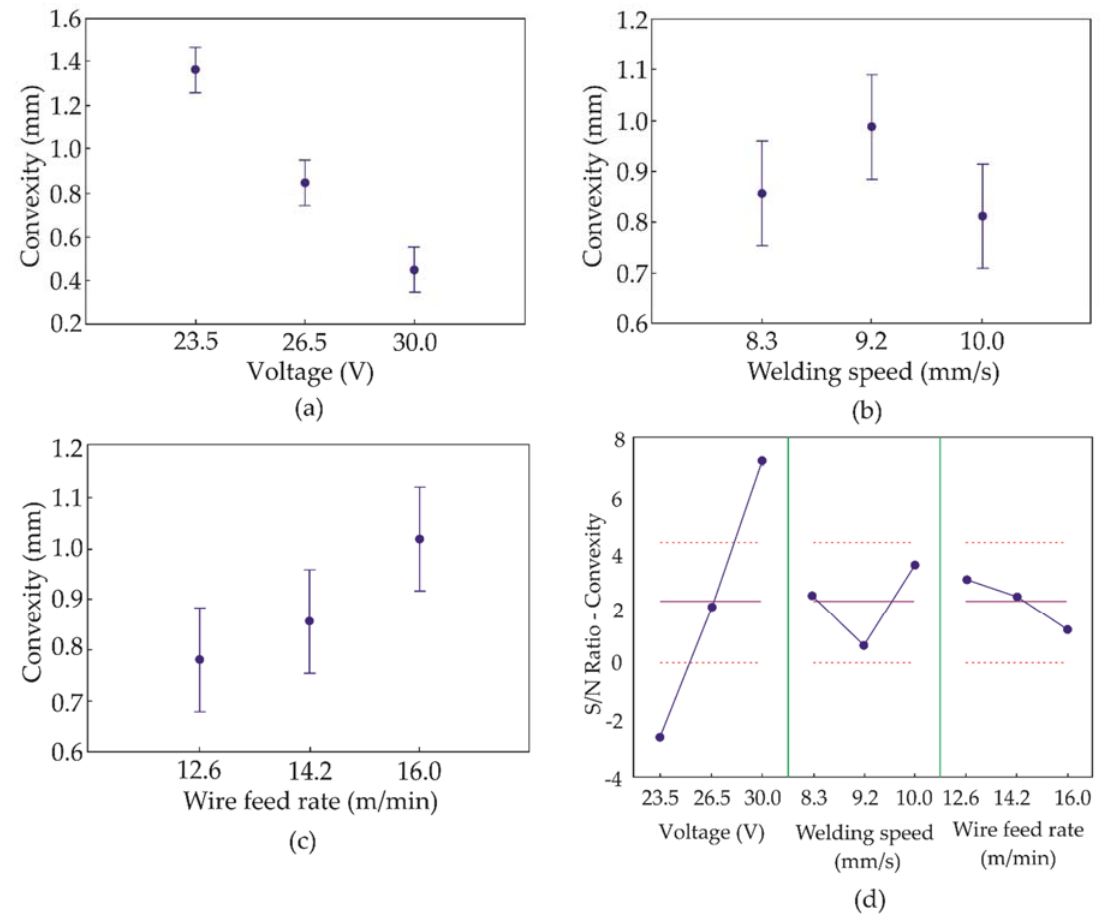
Figure 7. ( a ) Convexity as a function of voltage; ( b ) convexity depending on the welding speed; ( c ) convexity as a function of the wire speed rate; and ( d ) the S/N ratio of the width of the convexity for the factors analyzed.